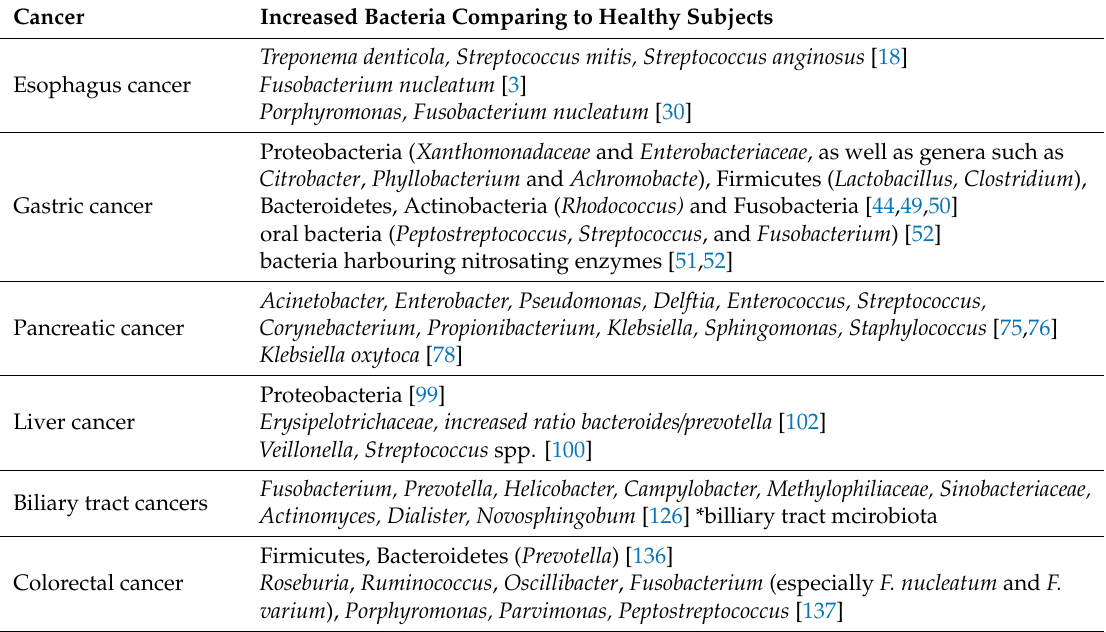
Table 8. Microbial signature of gastrointestinal